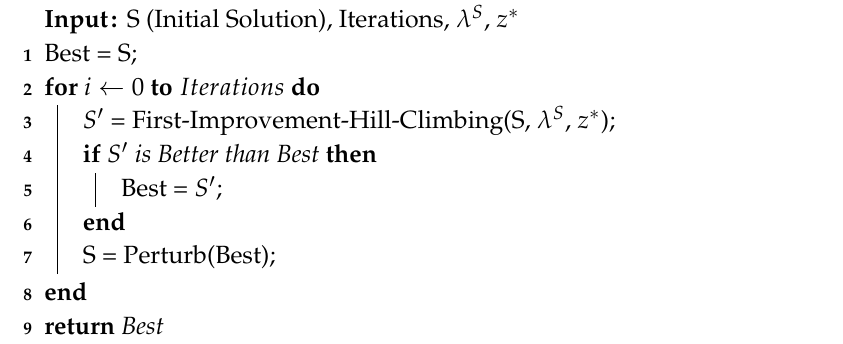
Algorithm 1: Iterated Local Search —